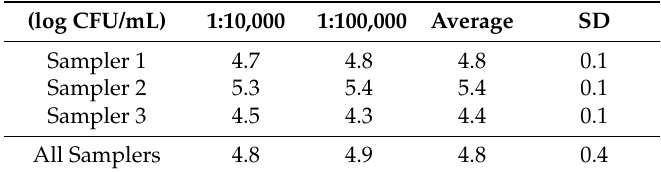
Table A5. Averages and standard deviation of the differences in sampling